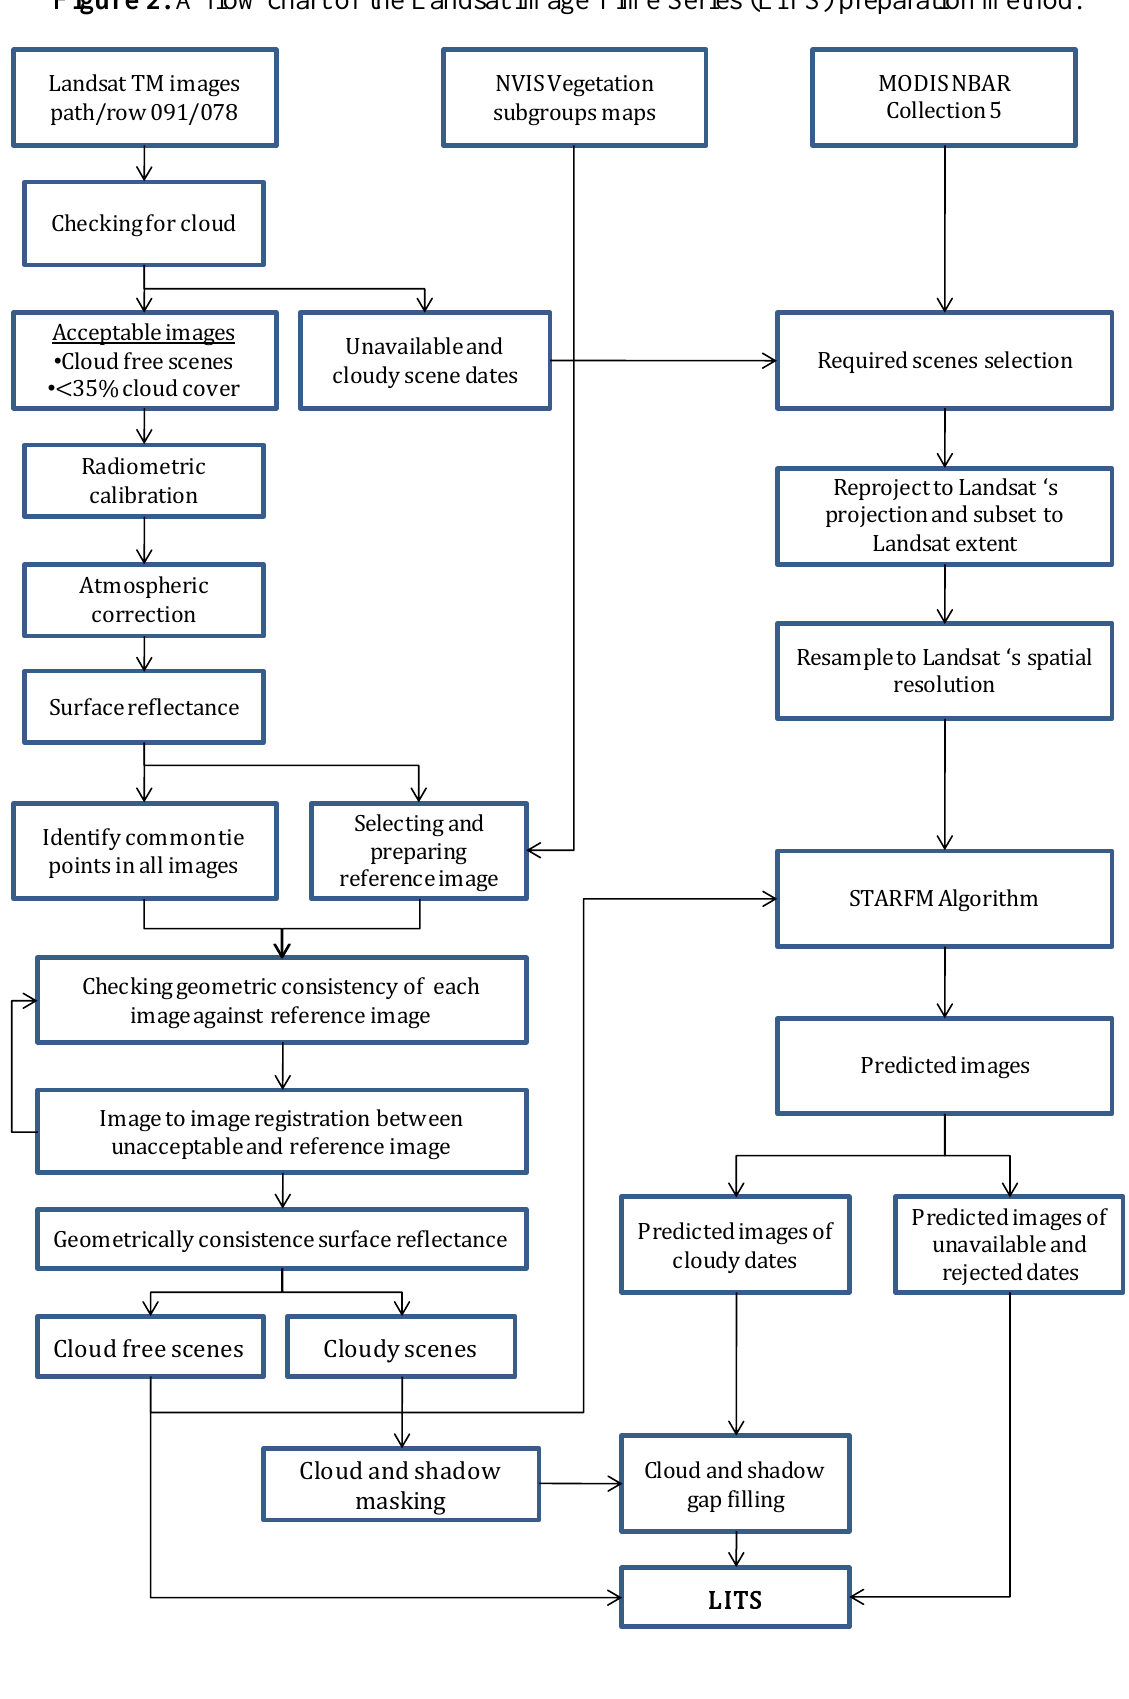
Figure 2. A flow chart of the Landsat Image Time Series (LITS) preparation